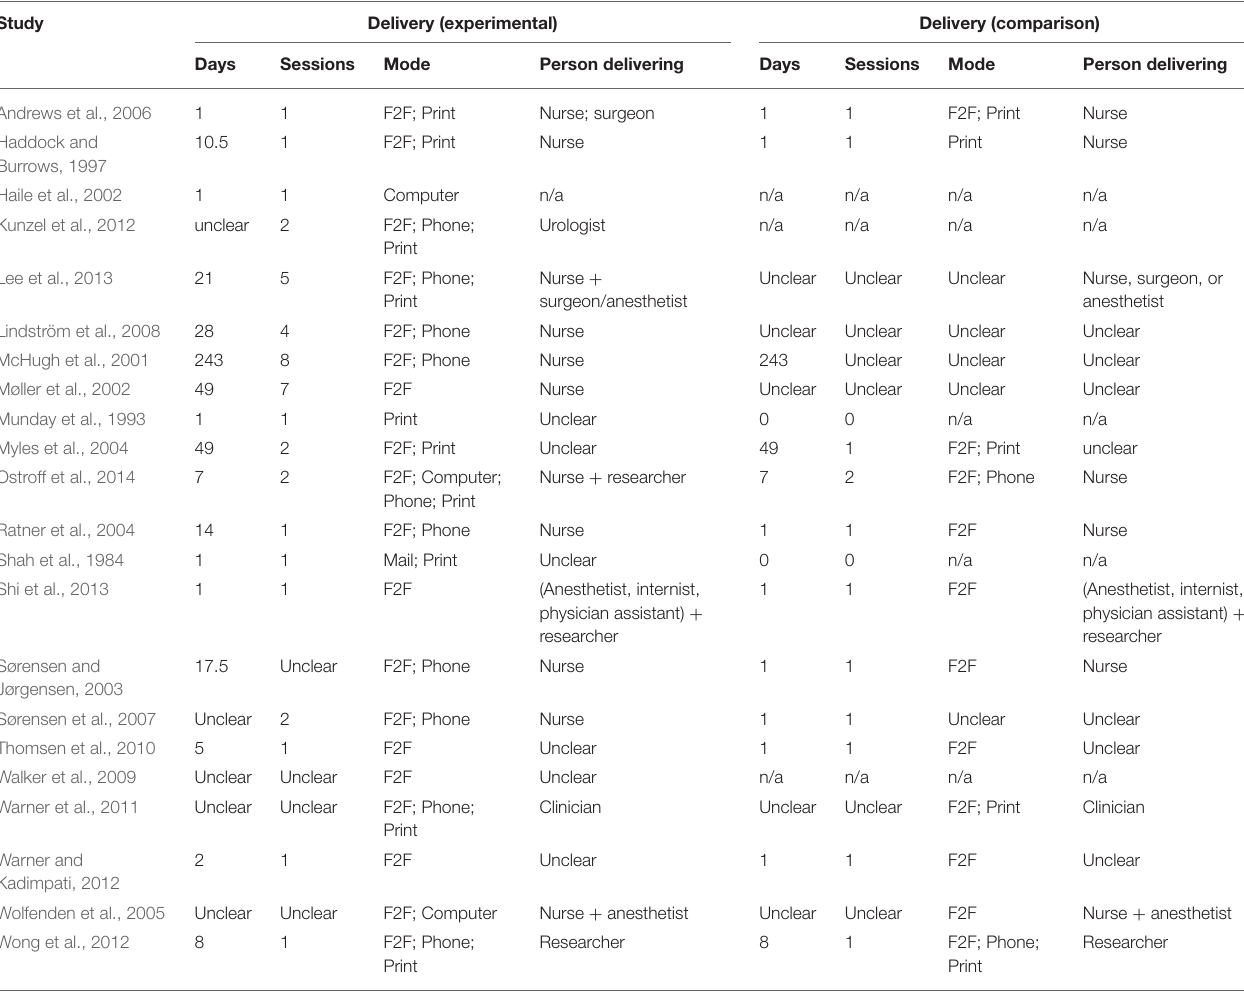
TABLE 2B | Characteristics of included